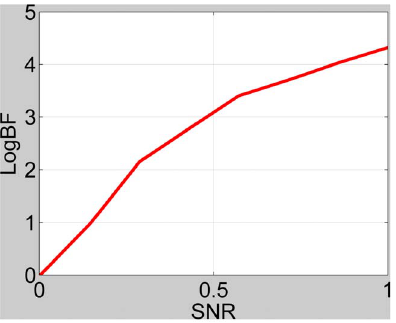
Figure 3. Log Bayes factor versus SNR for full versus reduced model, when reduced model is true, for IMO approach (black line) and Savage-Dickey (red line). The lines overlap.